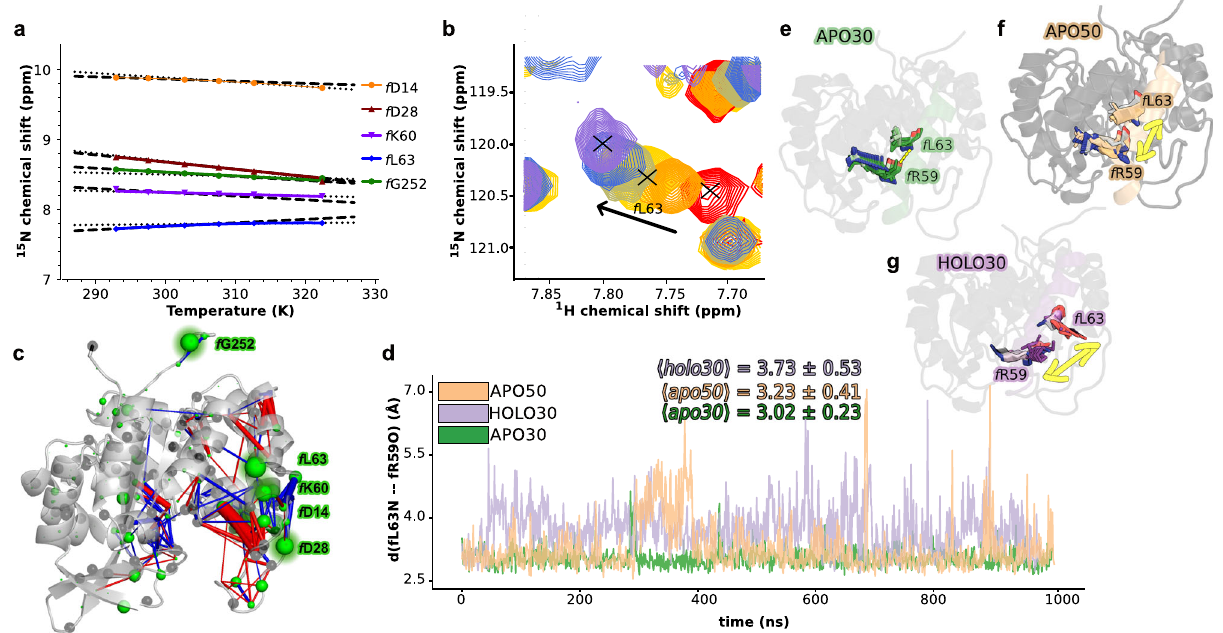
Fig. 4 | Temperature-dependent NMR chemical shifts and temperature- dependent molecular dynamics. a Experimental chemical shifts (relative to the APO state) of the fi ve residues with the biggest change in temperature coef fi cient around 30°C (between 292.9K and 302.7K, with slope displayed by dashed line) and around 50°C (between 307.6K and 322.4K, with slope displayed by dotted line).Typicalexperimentalerrorbarsforthetemperaturecoef fi cientsaretoosmall to be visualized (<1ppb). b Experimental spectral overlay for the most prominent change in NMR chemical shifts (i.e, NH of f L63) at all temperatures under con- sideration. c Superimpositionoftheexperimentaltemperaturecoef fi